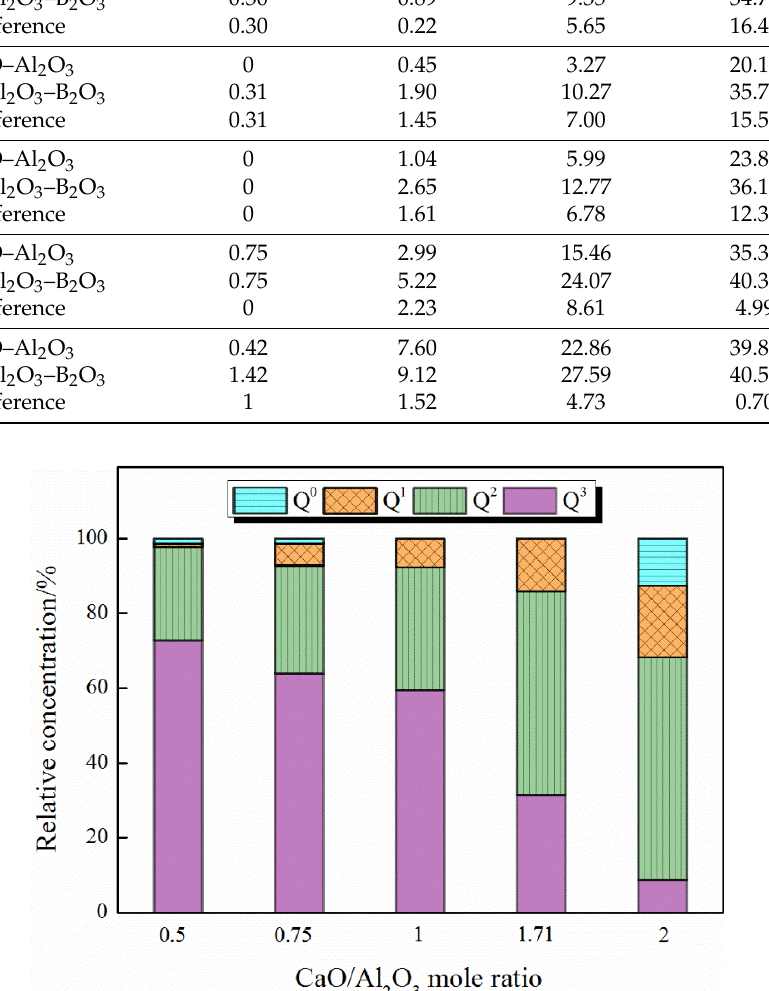
Figure 8. The effect of B 2 O 3 addition on the degree of transformation of Q 4 under different CaO/Al 2 O 3 mole ratios.